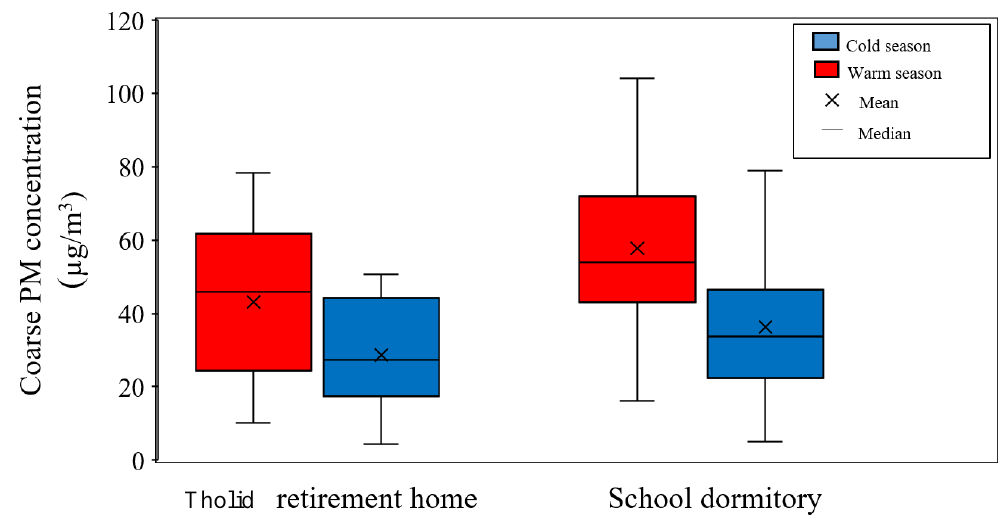
Figure 2. Seasonal variations of coarse PM concentrations at Tohid retirement home and School dormitory. Theboxesrepresentinter-quartilerange(25thto75thpercentile), whilewhiskersdemonstrate the 5th and 95th